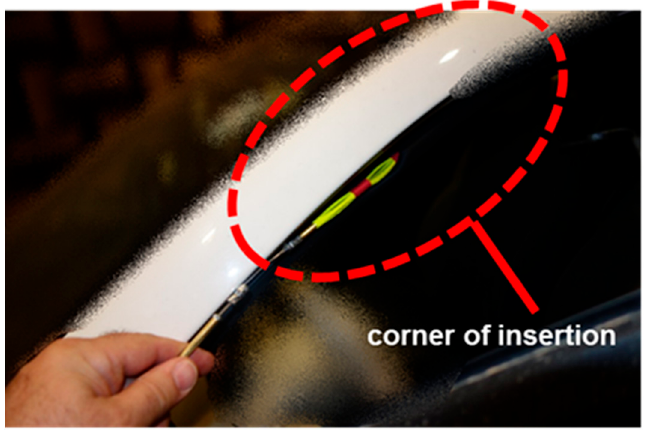
Figure 20. Integration of the SMA adaptive system within the door seal.